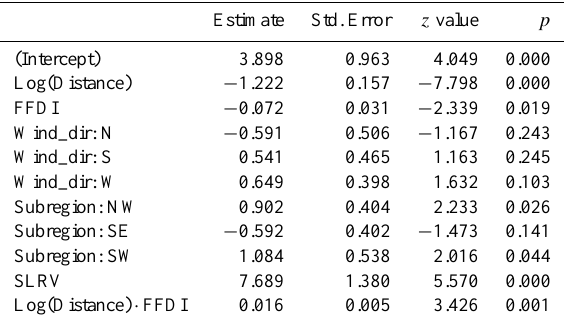
Table 2. Best model for predicting the probability that a fire will reach the WUI buffer ( n = 999, percentage of deviance captured = 35.83, AIC = 407.14, no supported alternatives). FFDI, Forest Fire Danger Index; SLRV, spatially lagged response variable (to control for spatial